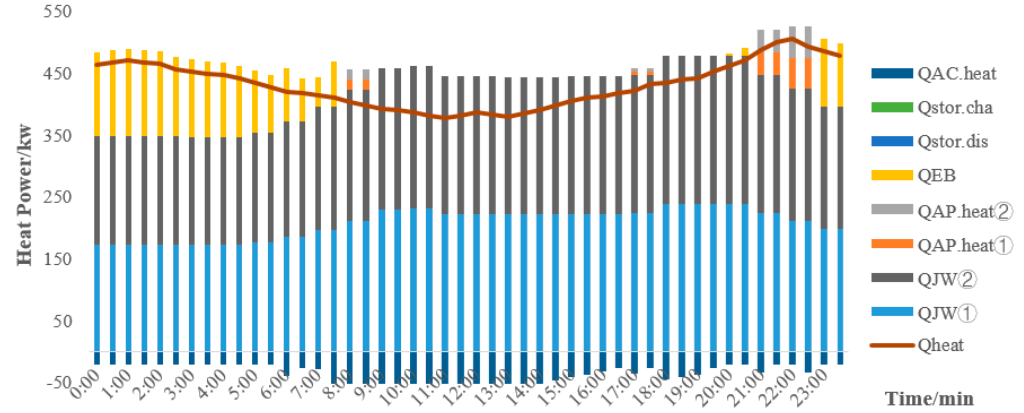
Figure 9. Heat output diagram of various equipment before multi-time scale in summer.